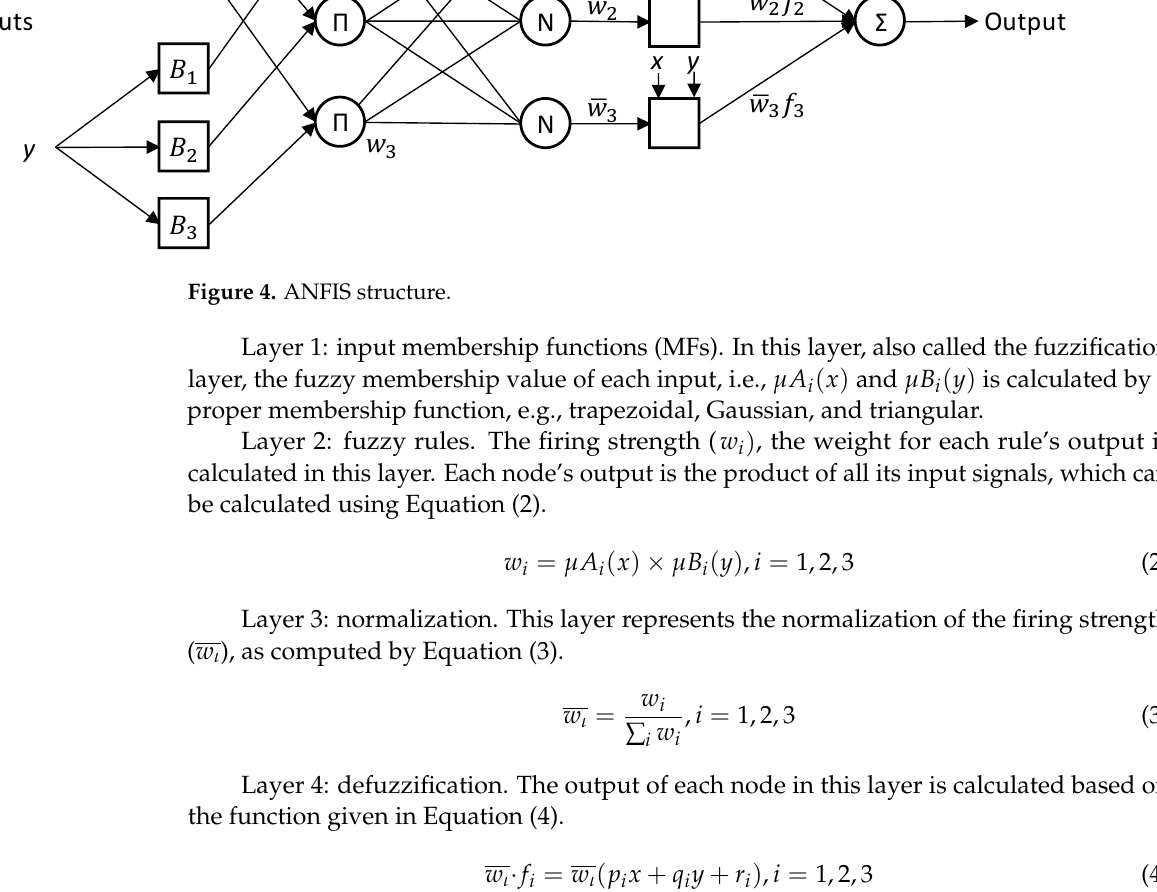
Figure 5. Methodology adopted in this study.